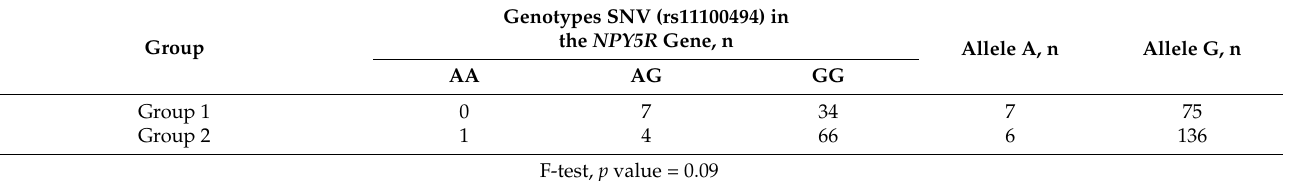
Table 4. Distribution of genotypes for studied SNVs in observation groups of patients with schizophre- nia spectrum